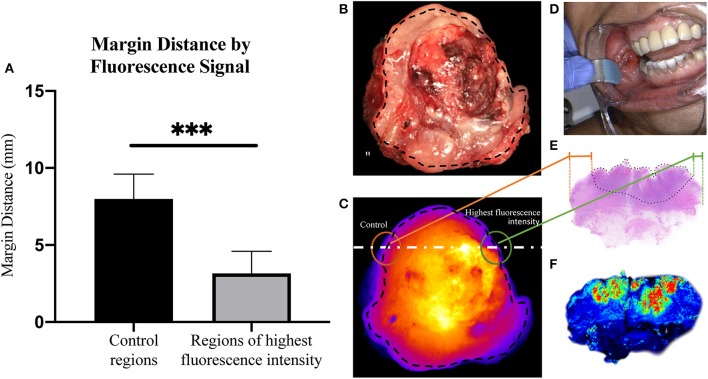
Margin distance by fluorescent signal. (A) Graph showing increase in margin distance at control regions when compared to sampled regions of highest fluorescence intensity. Representative brightfield image of resected tumor specimen (B) taken from buccal region in patient, seen in (D). (C) Corresponding closed-field fluorescent image of resected tumor specimen with black dotted line indicating overlaid circumferential mask, white dashed line indicating slice from which H&E slide (E) was taken, highlighting the difference in margin distance at the periphery between control region and region of highest fluorescence intensity. (F) High resolution image taken from Odyssey demonstrating fluorescence distribution within microscopic section. ***p < 0.0001.